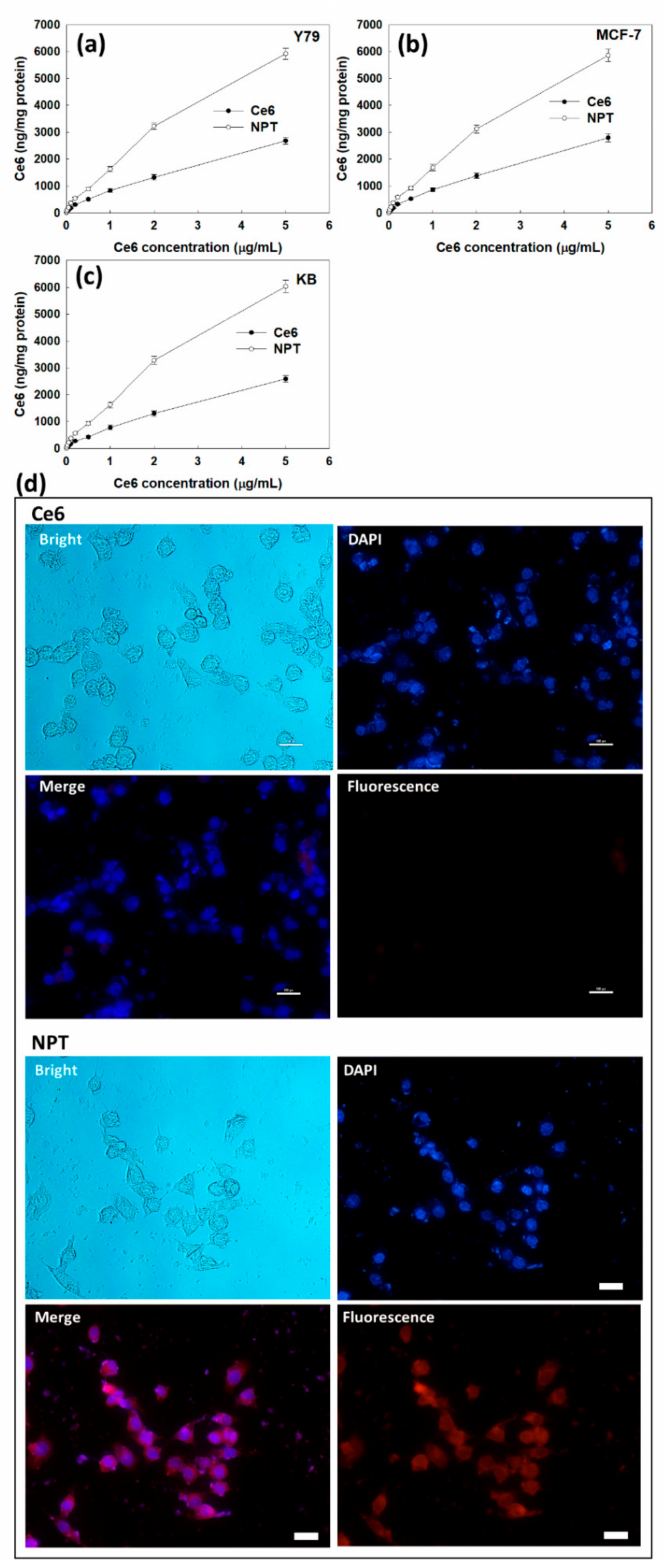
Figure 5. Ce6 uptake of Y79 cells ( a ), MCF-7 cells ( b ) and KB cells ( c ). Fluorescence observation of KB cells with treatment of Ce6 or nanophotosensitizers ( d ). Bar = 20 µ